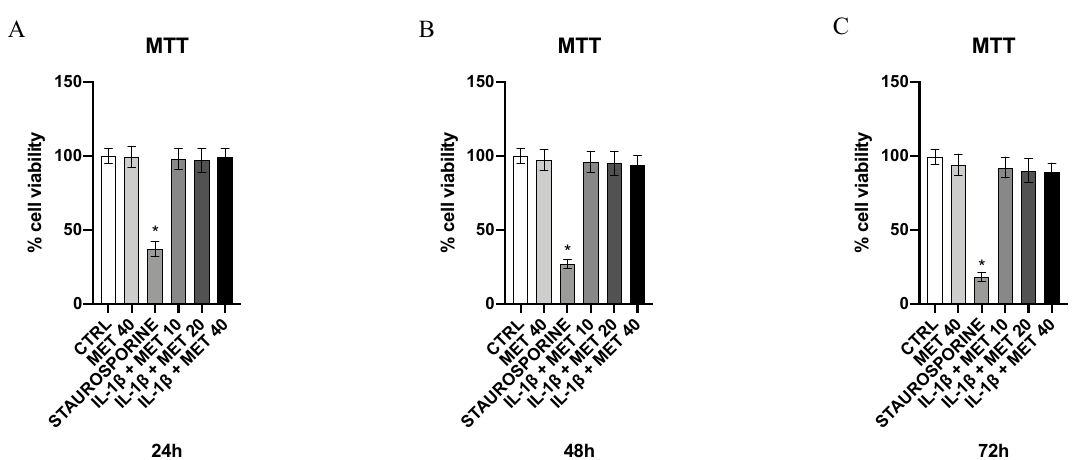
Figure 5. Effects of metaxalone on cell viability at 24 h ( A ), 48 h ( B ), and 72 h ( C ). Values are expressed as the means ± SD. *, p < 0.0001 vs. CTRL.